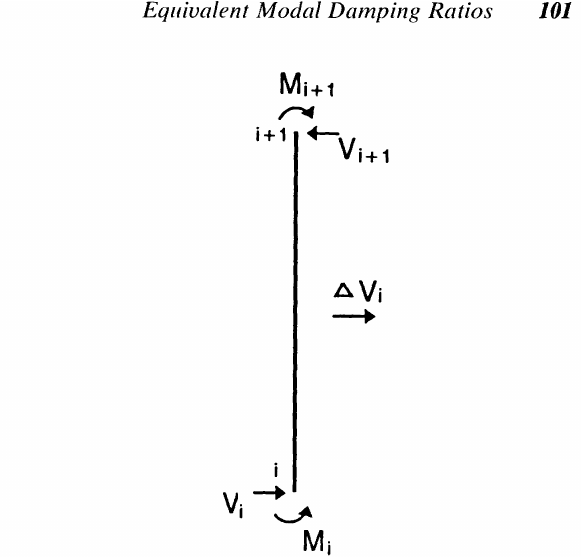
FIGURE 2 Transfer matrix model of structure el